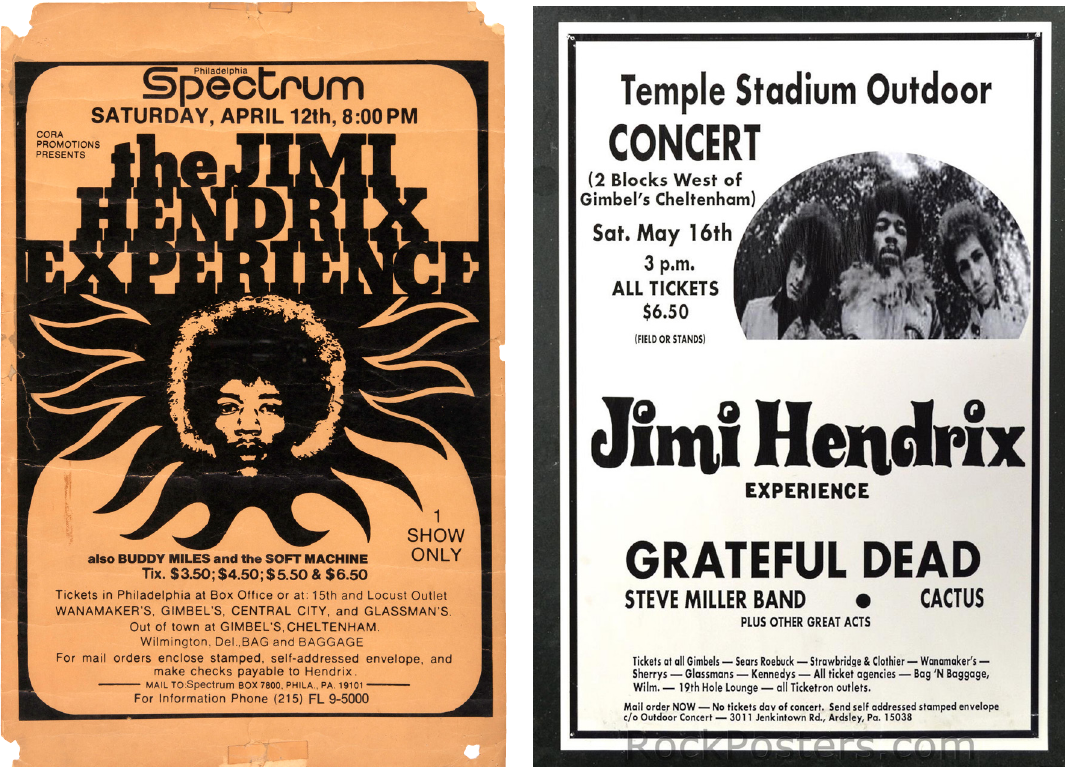
Figure 6. The Jimi Hendrix Experience Concert Poster, May 16, 1970. Temple Stadium, Philadelphia, PA.